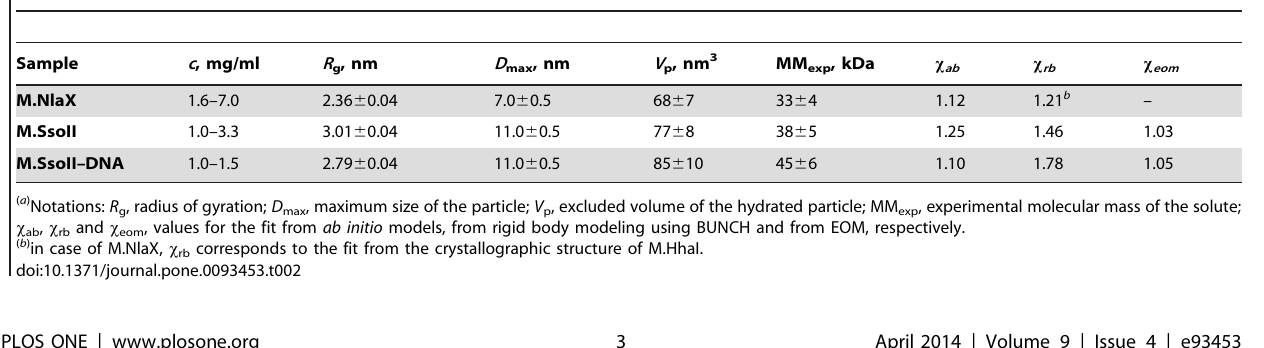
Table 2. Overall parameters calculated from SAXS a